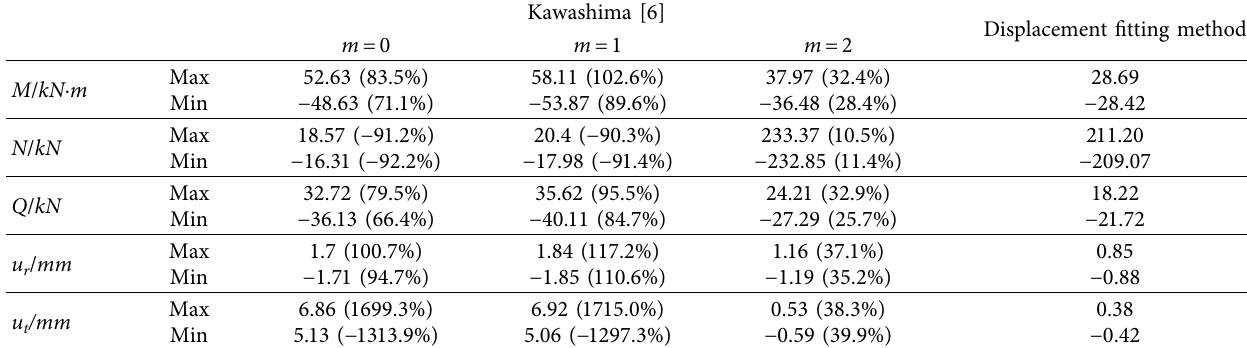
Table 5: The internal forces and displacement of the tunnel